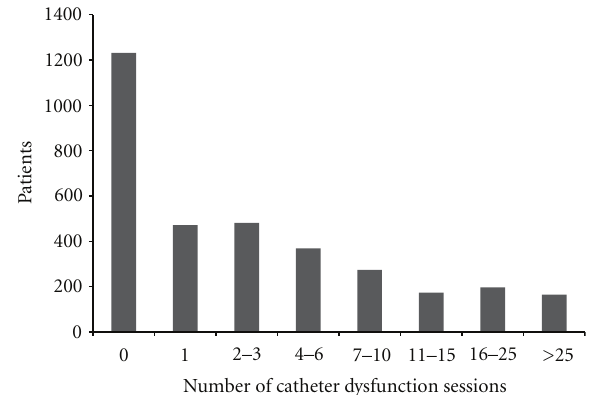
Figure 5: Frequency of catheter dysfunction Sessions. Catheter dysfunction was defined as unplanned blood flow rate during the dialysis session of <